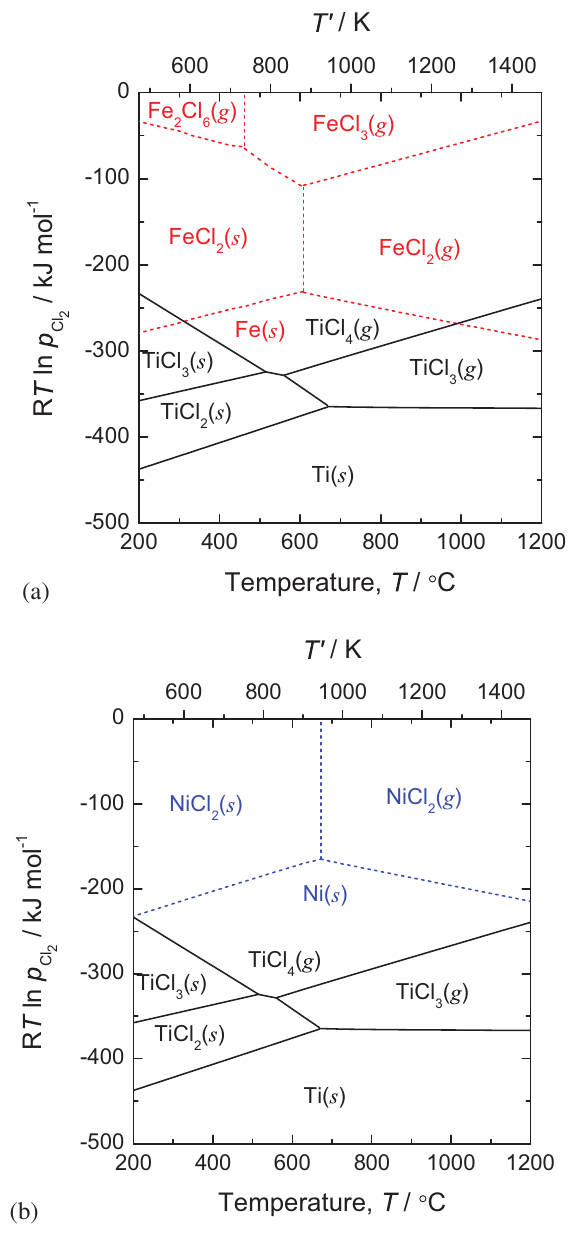
Figure 7. Chemical potential of chlorine (a) in the equi- libria of Ti, Fe and their chlorides, (b) in the equilibria of Ti, Ni and its chlorides. The solid line shows the bound- ary of Ti and its chlorides. The broken line indicates the boundary of Fe, Ni and its chlorides. It is assumed for cal- culation that the partial pressure of each gaseous species and the activity of solid species are 10 (cid:3) 3 atm and unity.